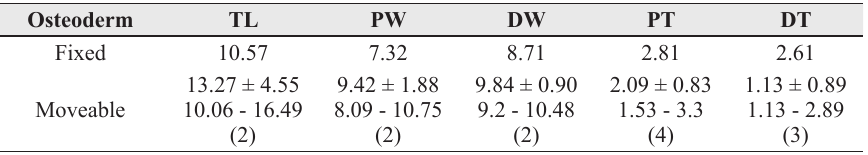
Measurements (mm) of preserved osteoderms assigned to Cabassous sp. Abreviations: TL, total length; PW, proximal width; DW, distal width; PT, proximal thickness; DT, distal thickness. When n >1, first line is mean ± standard deviation, second line is observed range, and third line is number of specimens measured